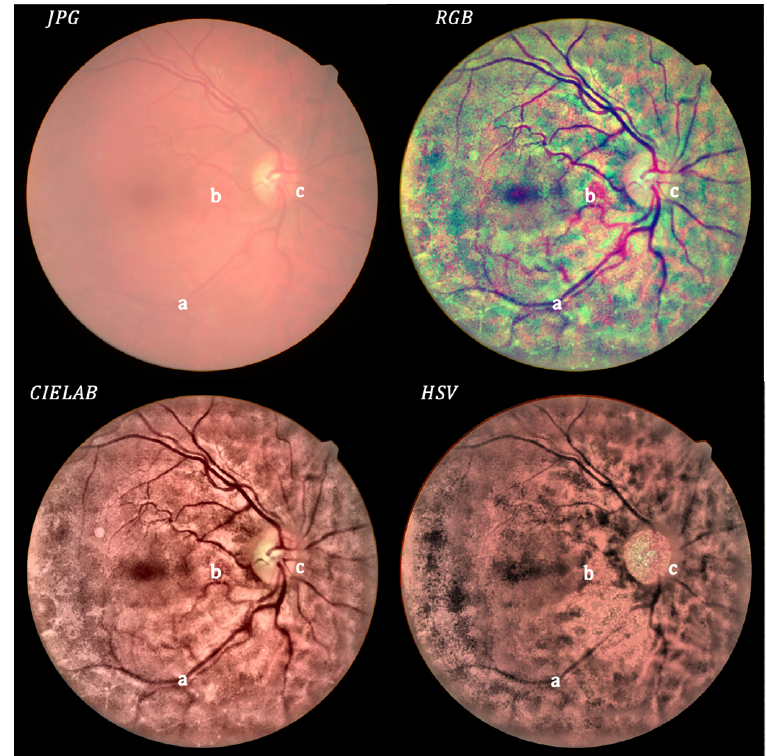
Figure 6. Mild cataract: original (upper left) and processed images.